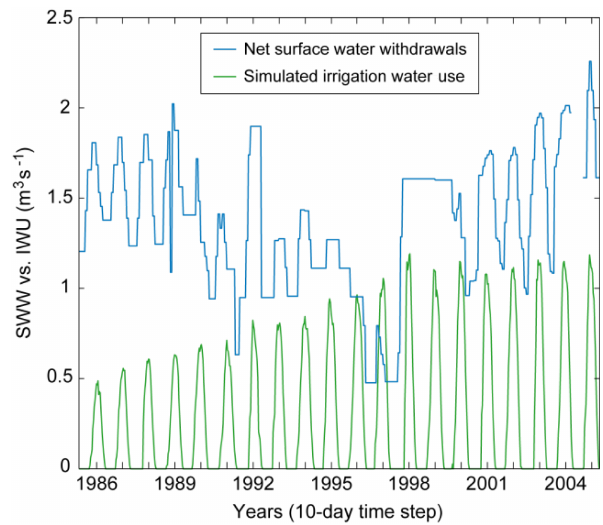
Figure 12. Comparison of net surface-water withdrawals (SWW) and irrigation water use (IWU) at the catchment scale: SWW were obtained by considering monthly restrictions to water access entitle- ments provided by the Chilean authorities, a conveyance efficiency of 0.6 and a field application efficiency of 0.6 for pisco varieties and 0.9 for table varieties; IWU was obtained from model